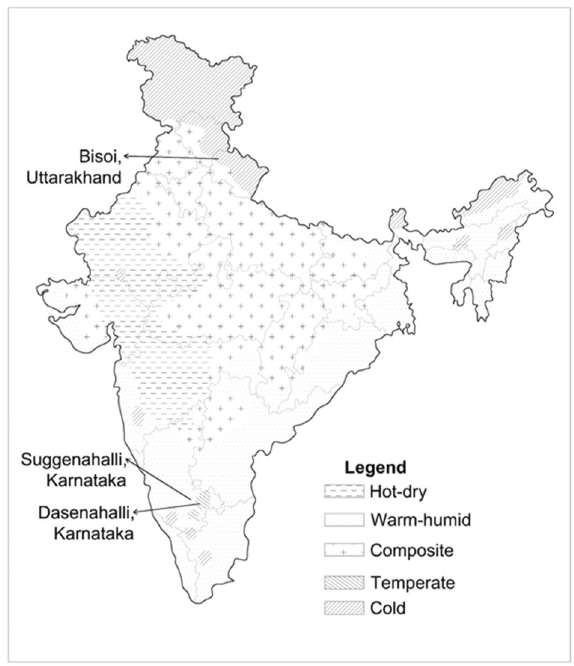
Figure 1. Climatic zones in India. (Adapted from National Building Code of India, 2005 22 ) and selected rural settlements: Figure shows the location of the rural settlements studied in this paper on the climate zone map of India. Suggenahalli lies in Warm-humid zone, Dasenahalli in Temperate zone and Bisoi in Cold zone. The authors used Autodesk AutoCAD 2018 (Product version: O.49.0.0 AutoCAD 2018) https:// www. autod esk. com/ produ cts/ autoc ad/ overv iew? suppo rt= ADVAN CED& plc= ACDIS T& term=1- YEAR& quant ity=1 to draw the map and mark the rural settlements on it.